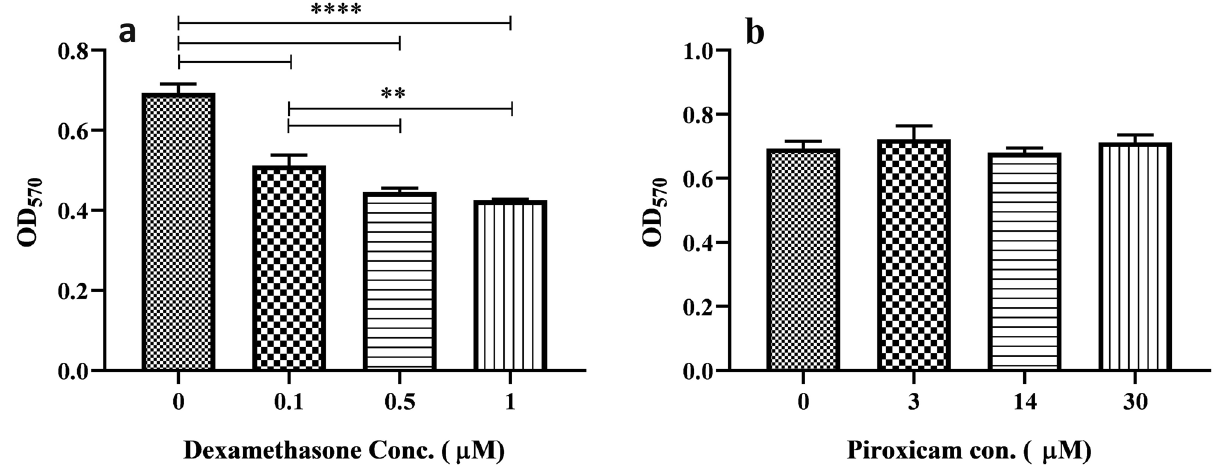
Figure 1. The effect of drugs on the proliferation of T cells in PBMCs. The effect of three different concentrations of dexamethasone ( a ) and piroxicam ( b ) was assessed on the proliferation of T cells in PBMCs (n = 3). The graphs show the mean ± SD. Significant changes are indicated with asterisk (* p < 0.05, ** p < 0.01, *** p < 0.001, **** p < 0.0001).